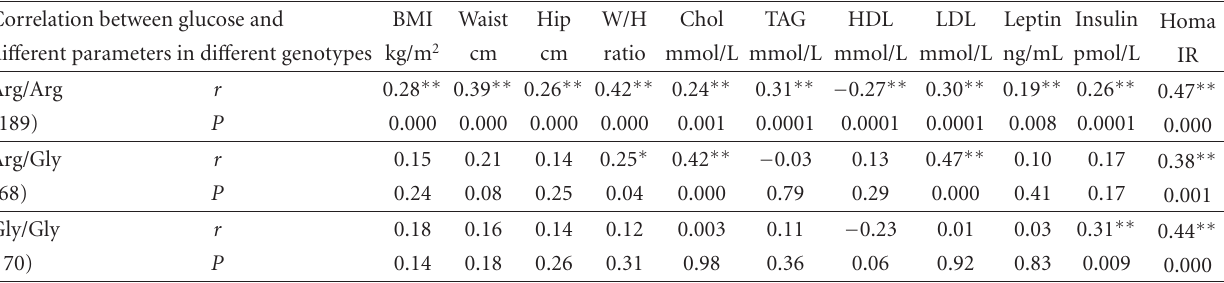
Table 5: Correlation between fasting glucose and the anthropometric parameters and lipids in individuals with di ff erent Arg16Gly